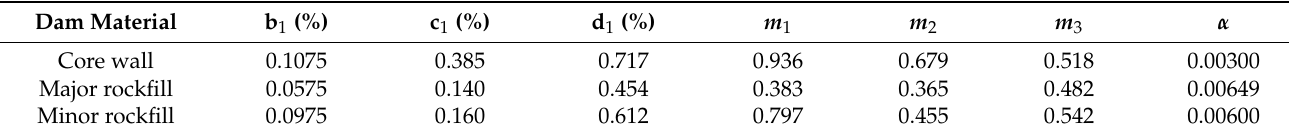
Table 3. Pubugou Dam materials’ creep model parameters.